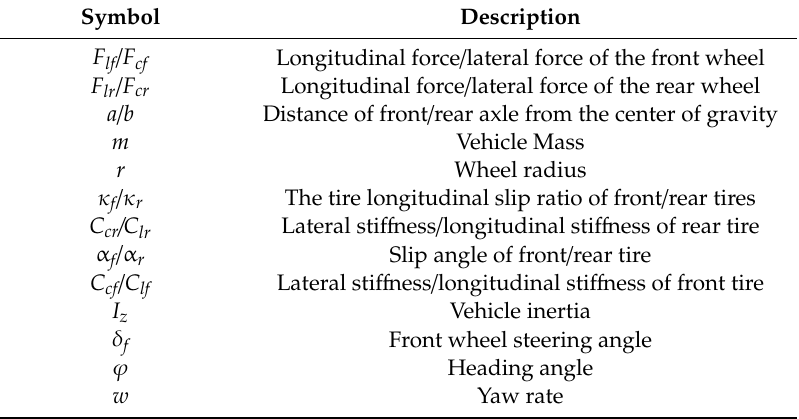
Figure 2. Vehicle dynamics model. Table 1. Bicycle model parameters.